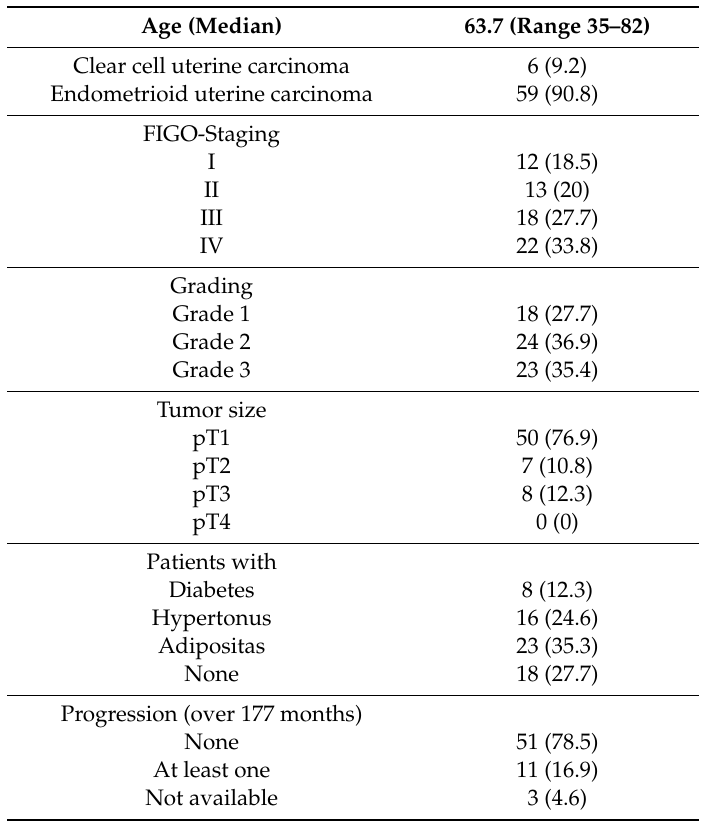
Table 3. Patients’ characteristics (endometrial carcinoma, n =